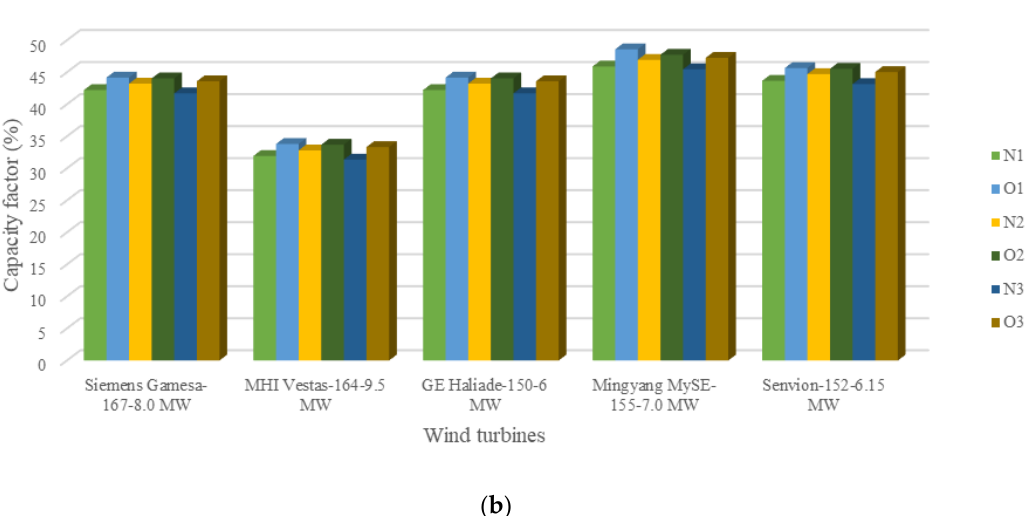
Figure 6. ( a ) Annual energy production and ( b ) capacity factor expected from each type of turbine for six sites in Black Sea using the wind data for the distant future.